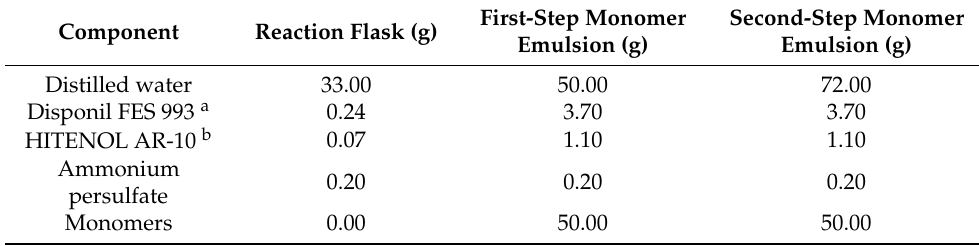
Table 3. Components of the polymerization mixture with different